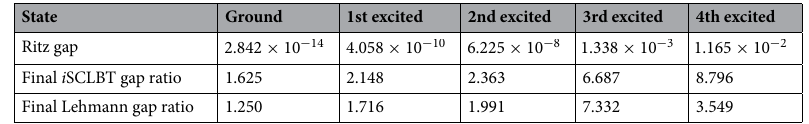
Table 2. Ritz gaps and the final i SCLBT and Lehmann gap ratios at L ∗ = 5 calculated at L = 65 for the Heisenberg